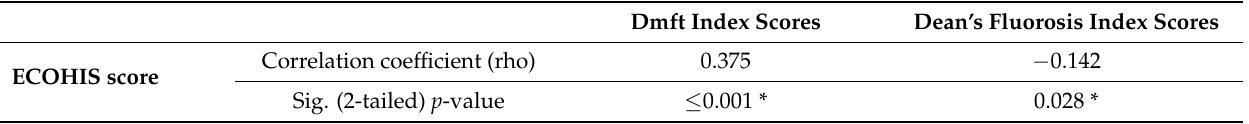
Table 5. Correlation between the